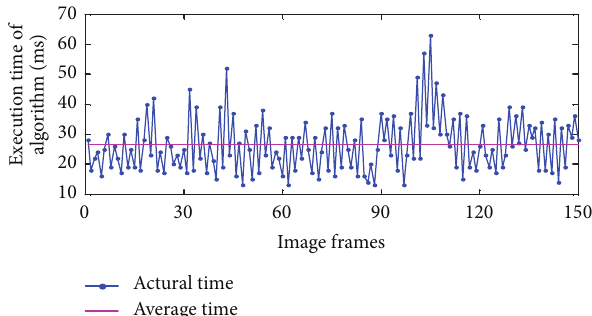
Figure 13: The efficiency of VPFE algorithm.